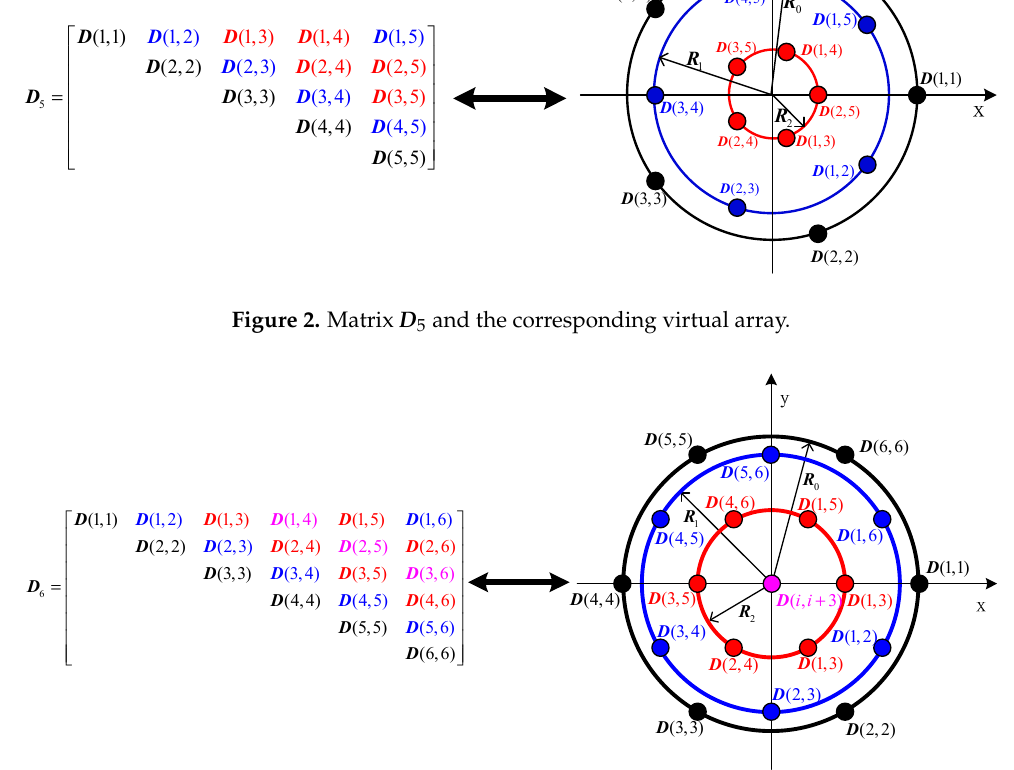
Figure 3. Matrix D 6 and the corresponding virtual array.